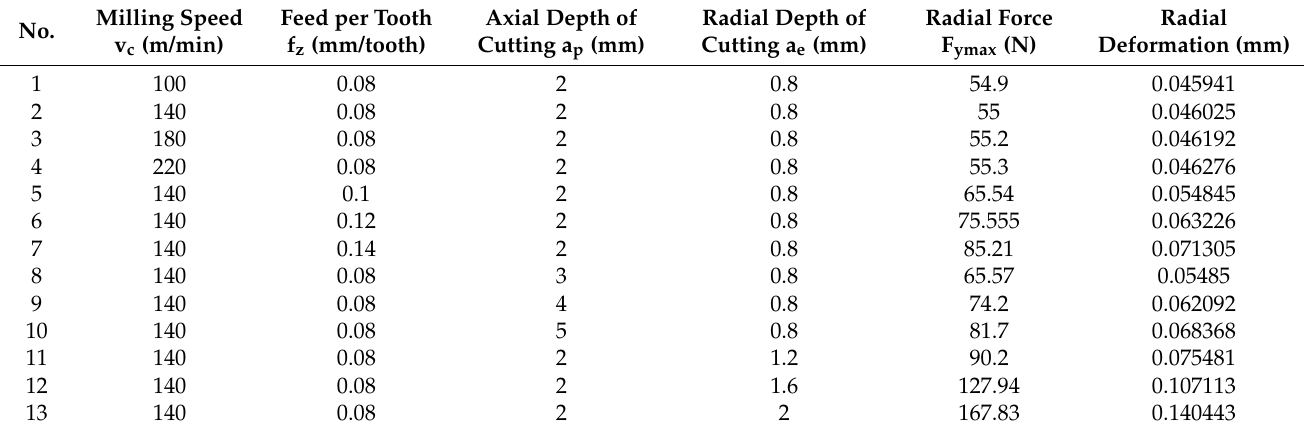
Table 4. Table of cutting